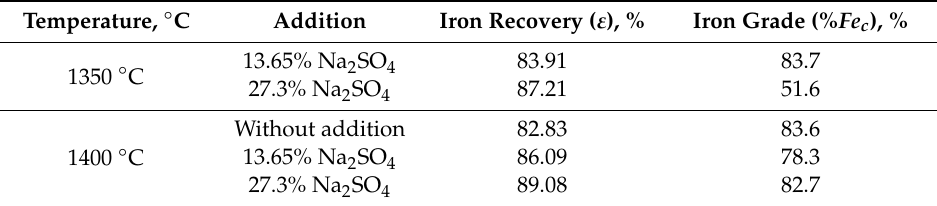
Table 5. The magnetic separation indexes of the reduced samples U with Na 2 SO 4 addition. Temperature, ◦ C Addition